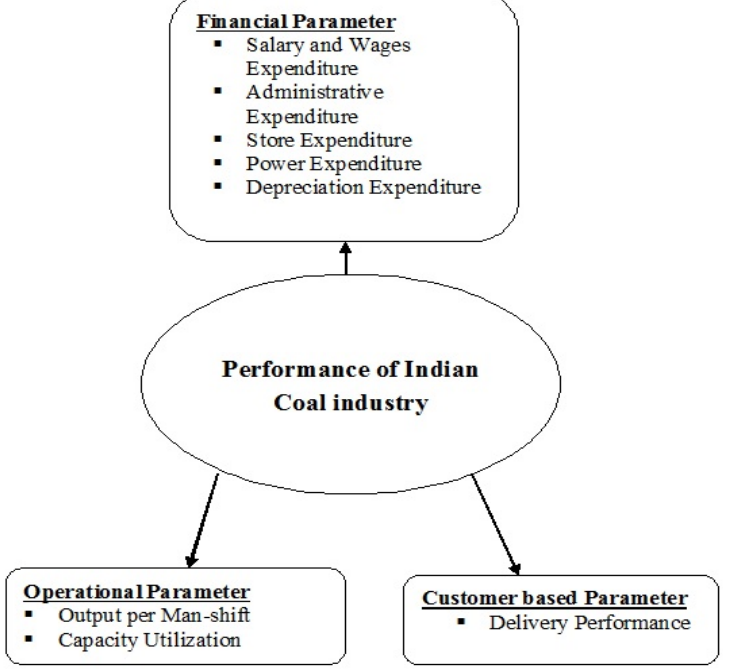
Figure 1. The Performance measurement indicator.